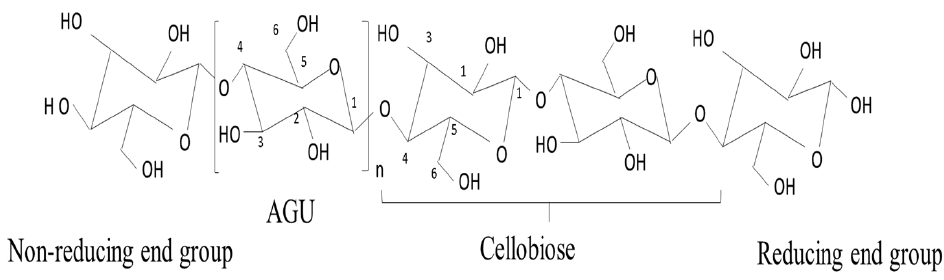
Figure 4. Structure of cellulose with the carbon atoms numbered, showing the repeating cellobiose unit in cellulose (adapted and modified from Marinho [53]).